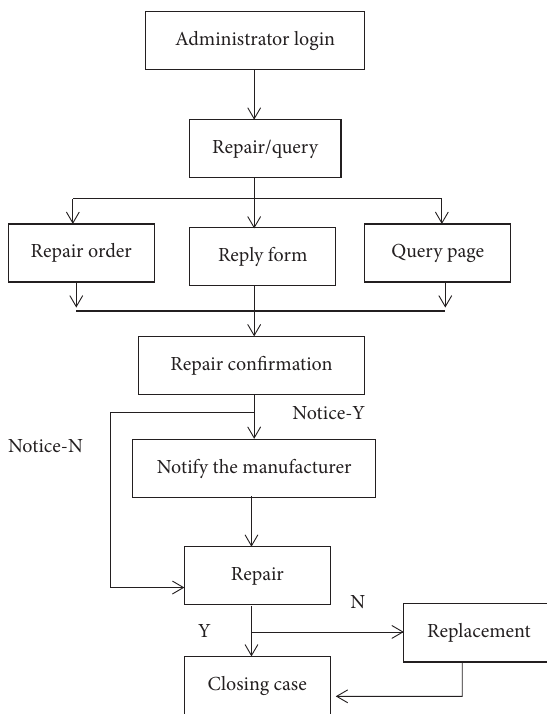
Figure 1: The conventional repair